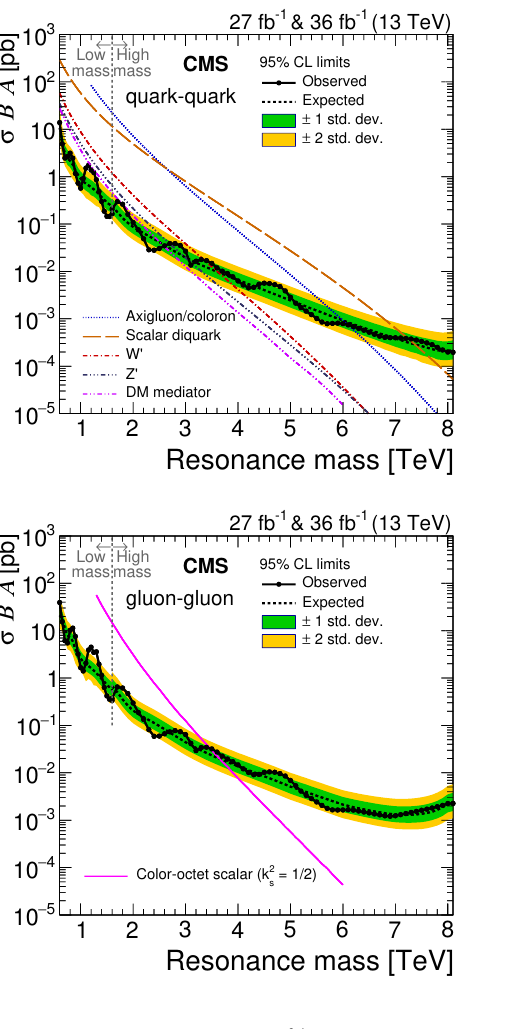
Figure 11 . The observed 95% CL upper limits on the product of the cross section, branching fraction, and acceptance for dijet resonances decaying to quark-quark (upper left), quark-gluon (upper right), gluon-gluon (lower left), and for RS gravitons (lower right). The corresponding expected limits (dashed) and their variations at the 1 and 2 standard deviation levels (shaded bands) are also shown. Limits are compared to predicted cross sections for string resonances [23, 24],